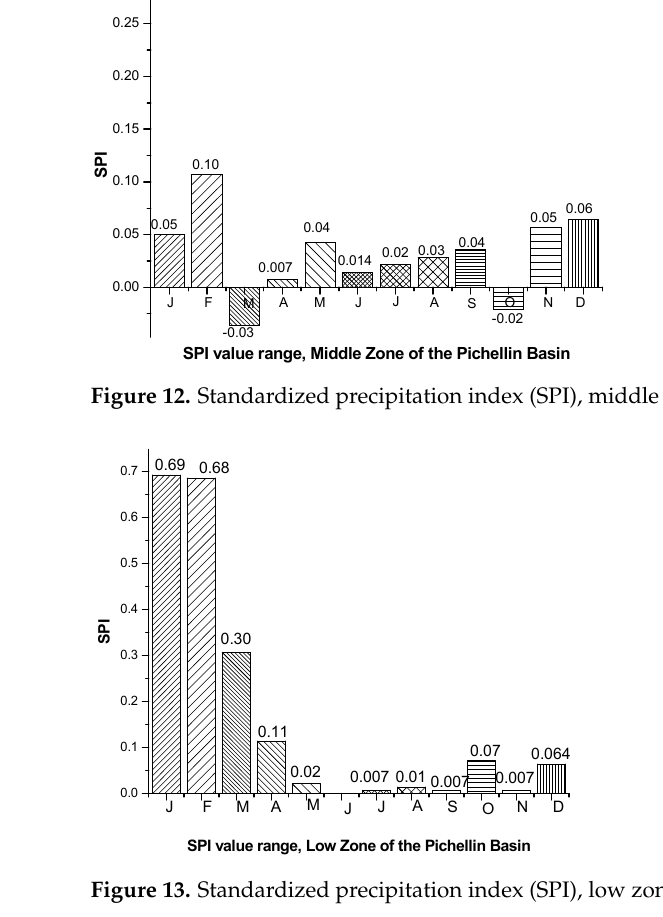
Figure 13. Standardized precipitation index (SPI), low zone.